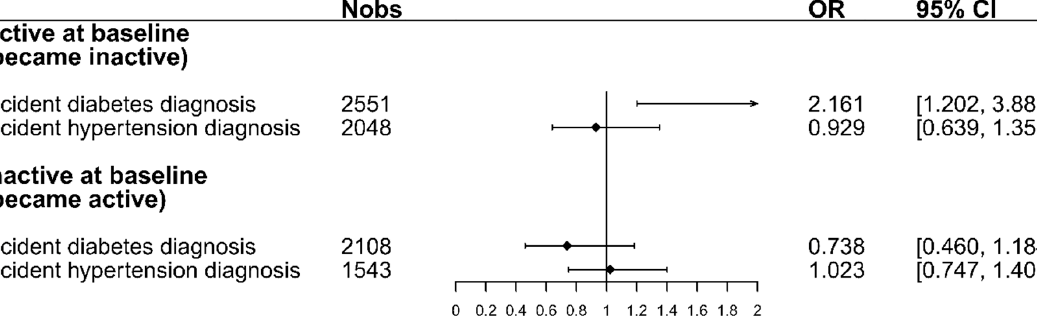
Figure 3. The odds-ratios for changing PA after a diabetes / hypertension diagnosis for both baseline PA strata. ORs for the active stratum display the odds of changing to inactive. ORs for the inactive stratum display the odds of changing to active. All models were adjusted for the following factors: sex, age, education, family status, baseline BMI, change in BMI, and change in physical and mental health-related quality of life. Abbreviations: Nobs = Number of observations, OR = Odds ratio, 95% CI = 95% Confidence